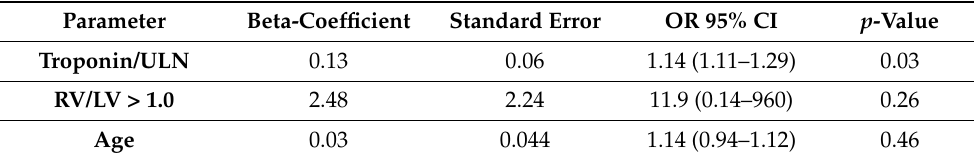
Table 4. Predictors of study outcomes by multivariable logistic regression analysis. ULN—upper limit of normal.